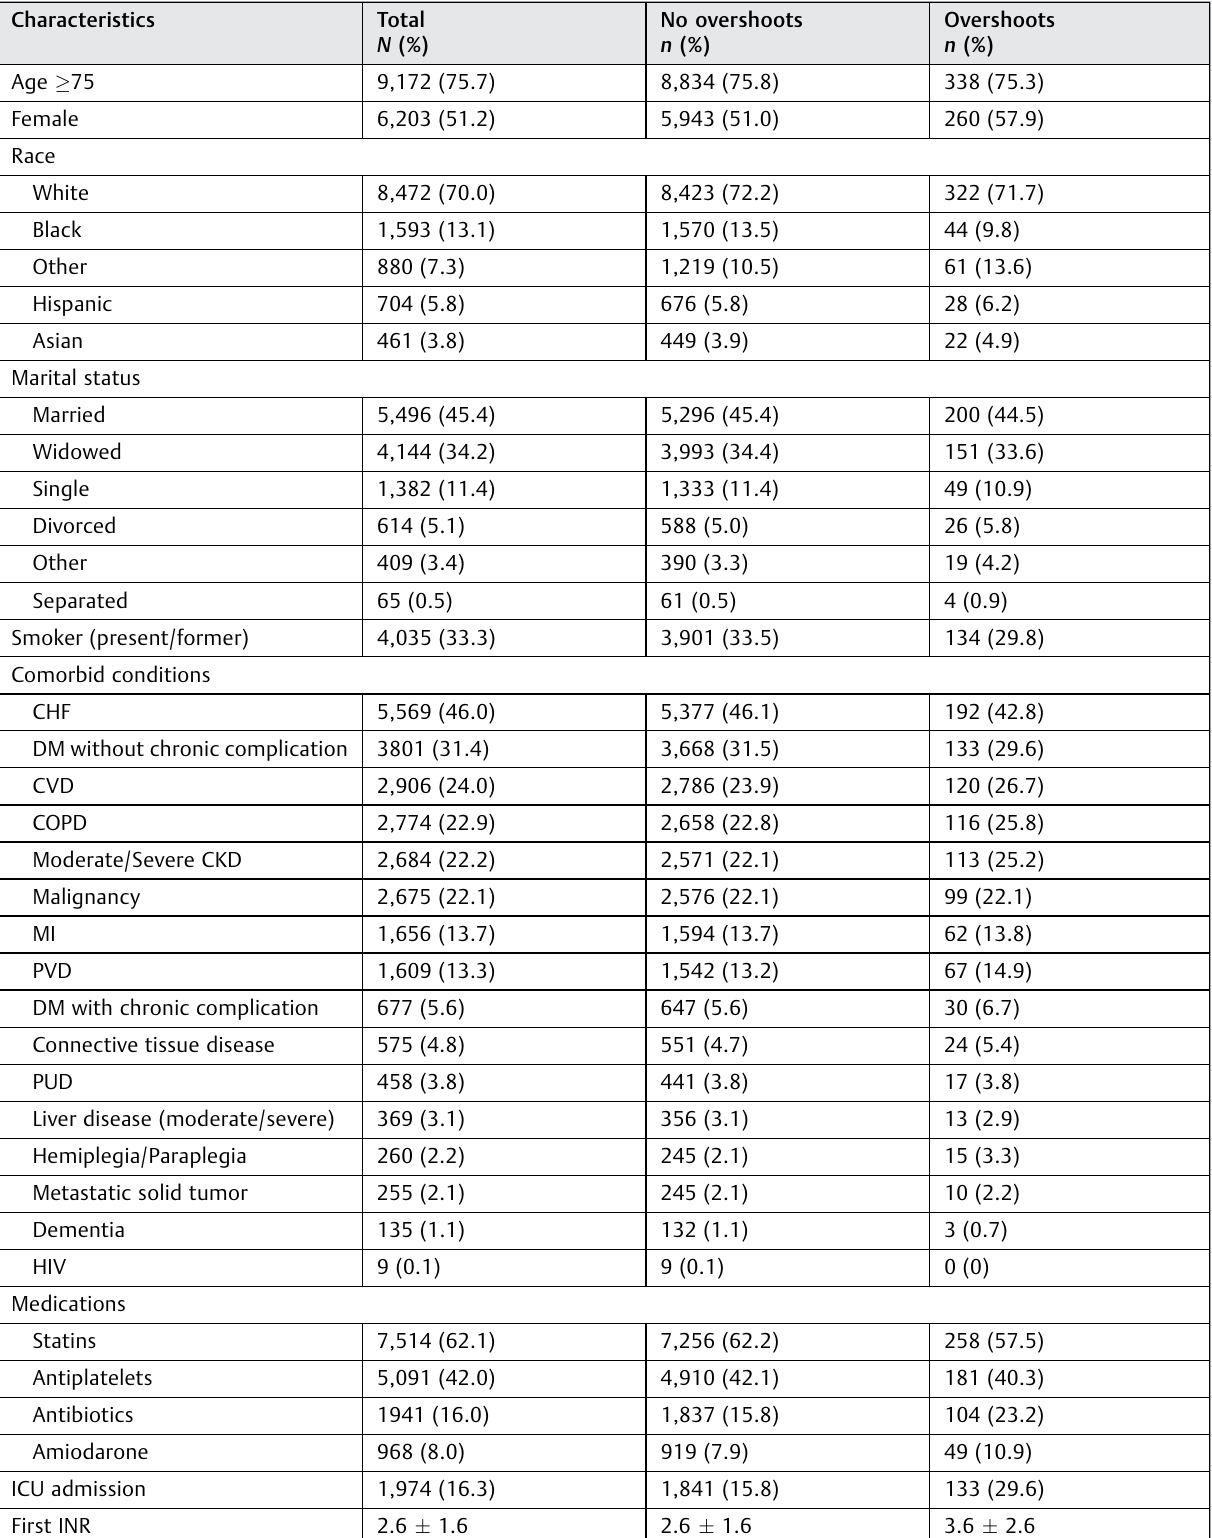
Table 1 Patient characteristics: 12,107 chronic warfarin inpatients